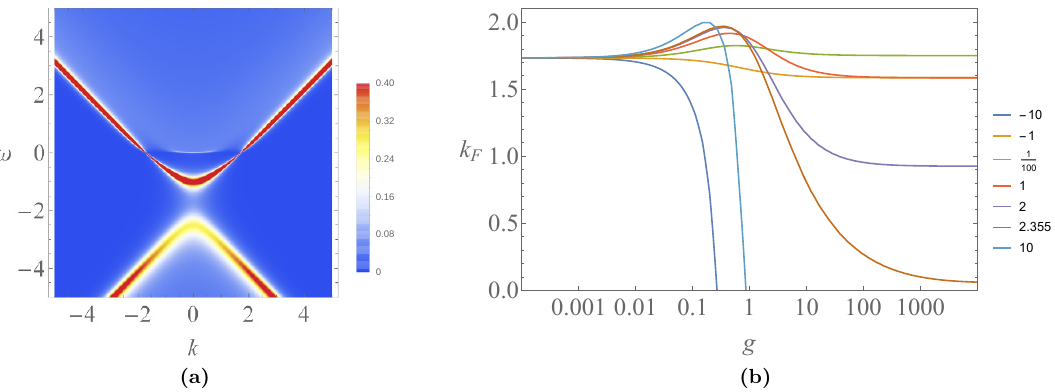
Figure 11 . (a) The spectral function for (cid:22) = 2, (cid:21) = 1 and g = 4. There is a Fermi surface at k F = 1 : 72. (b) The Fermi momentum k F as a function of g . The legend shows the value of the coupling (cid:21)